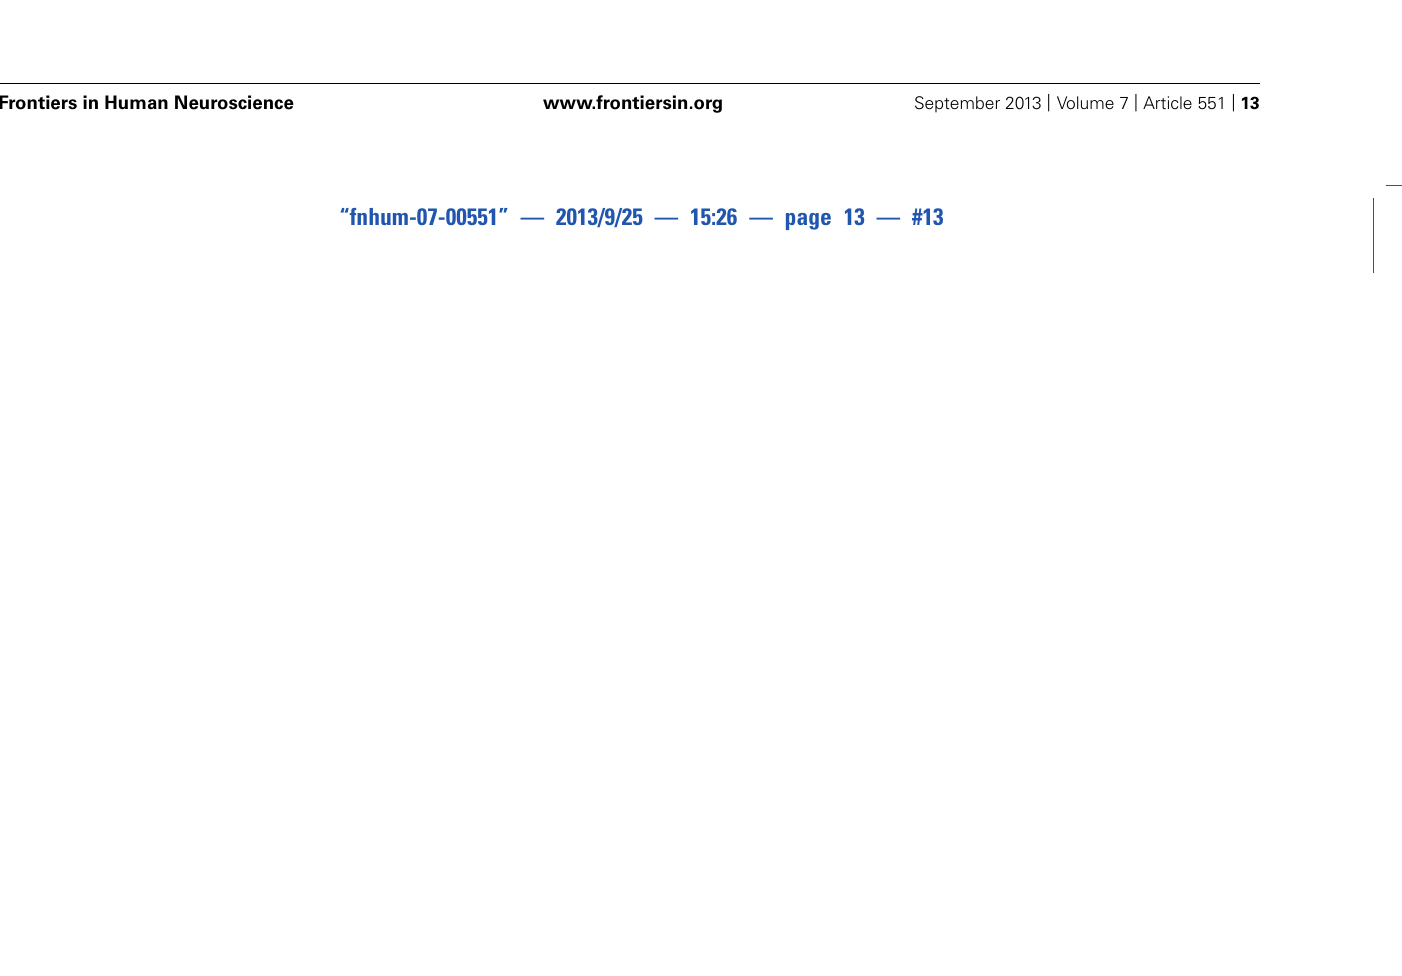
with statistically significant correlations after the subject-wise validation ( Table 3 ). Graphs in gray squares represent constant processing without statistically significant correlations. Error bars denote SEM. R: the group-wise correlation coefficient. p (Valid.): probability after the subject-wise validation ( Table 3 ). (A) The right FFA; (B) the left insula; (C) the left amygdala; (D) the mPFC; (E) the right OFA; and (F) the right